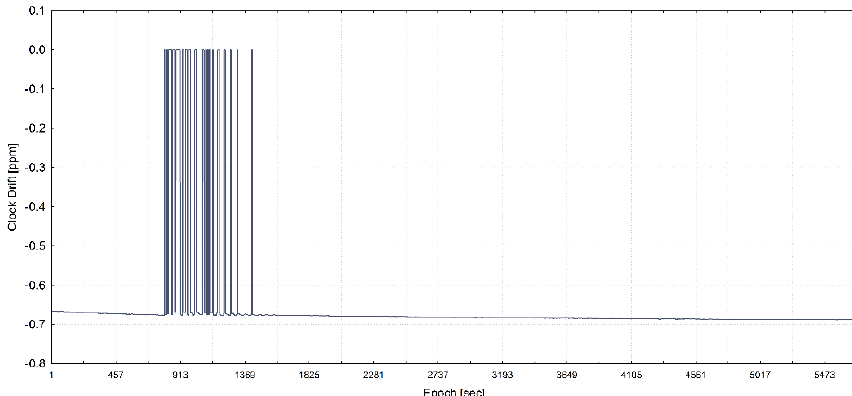
Figure 5. Receiver clock drift from the training dataset with a programmed 5 ns / s of time pulling